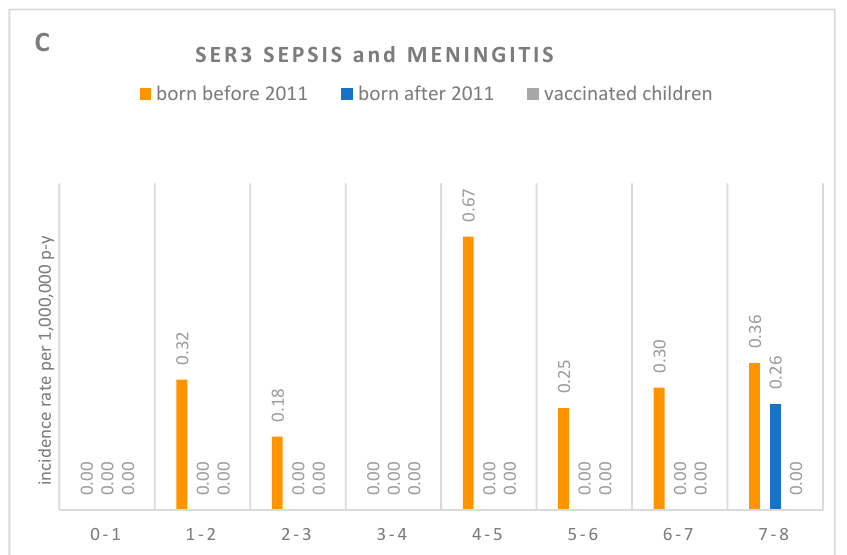
Figure 2. Age-specific incidence rates of serotype 3 Streptococcus pneumoniae (ser3) invasive pneumococcal disease (IPD) ( A ), pneumonias ( B ), and severe systemic infections (sepsis and meningitis) ( C ). Each subgroup refers to a one-year age class (ranging from 0–1 year old to 7–8 year old children) and shows incidence rates in children born before PCV13 introduction in the Italian vaccination calendar (2011), in children born after 2011, and in children born after 2011 and vaccinated. Age-specific rates were determined for intervals of one year of age (e.g., “3–4” stands for “patients with age ≥ 3 and < 4 years of age”). P-y: person-years. Table 1. Incidence rates (first row), age standardized incidence rates (ASR) (second and third row), and 95% confidence intervals of serotype 3 (ser3) invasive pneumococcal disease (IPD), ser3 pneumonias, and ser3 severe systemic infections (sepsis and meningitis) in Italian children under 8 years of age born before 2011, after 2011, and vaccinated with PCV13. Incidence rates refer to 1,000,000 person-years. NaN: not available number.